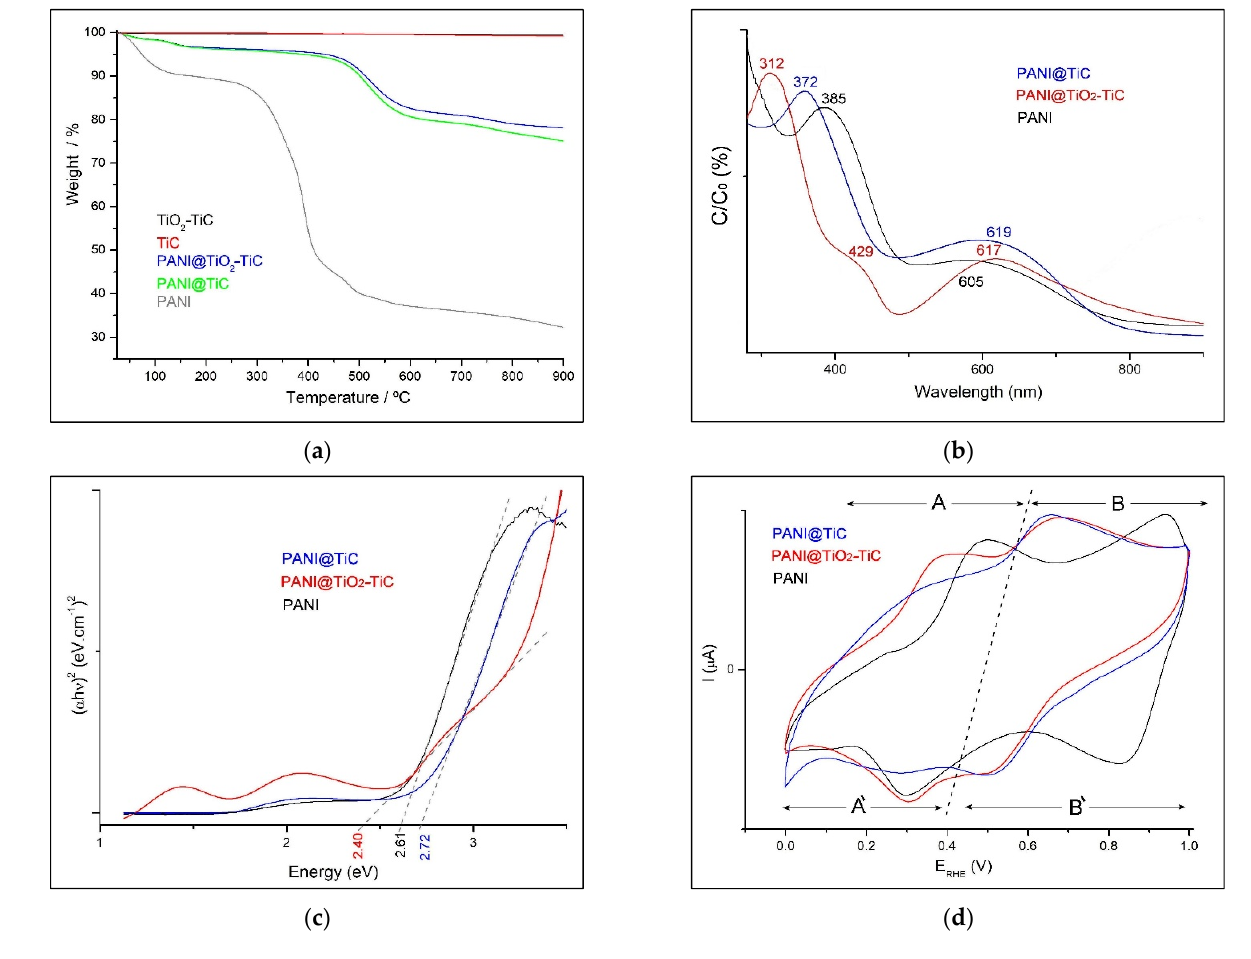
Figure 7. ( a ) Thermogravimetric analysis (TGA) curves; ( b ) UV–vis spectroscopy absorption spectra; ( c ) Tauc plots; and ( d ) samples’ responses to cyclic voltammetry .